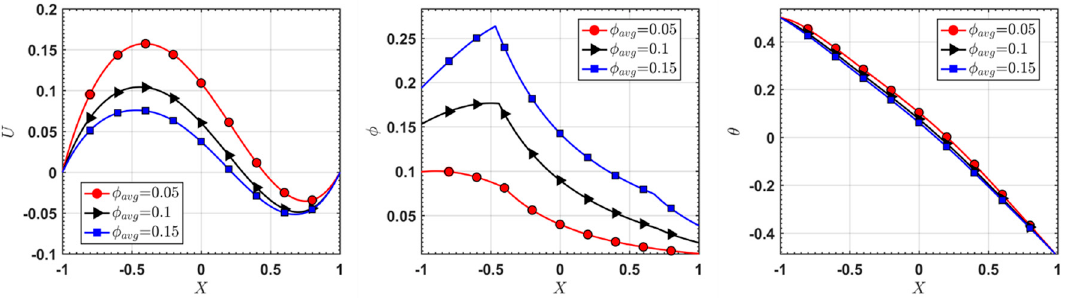
Figure 10. E ff ect of bulk (average) concentration ( φ avg ) on the velocity, concentration and temperature Figure 10. Effect of bulk (average) concentration ( 𝜙 ) on the velocity, concentration and temperature 𝑎𝑣𝑔 ◦ profiles, when Γ c = 1.0, Γ µ = 0.1, Γ g = 1, β = 10 , Le = 10, n = − 0.5, δ = 1, Ra = 2 and Br = profiles, when 𝛤 𝑐 = 1.0 , 𝛤 𝜇 = 0.1 , 𝛤 𝑔 = 1 , 𝛽 = 10° , 𝐿𝑒 = 10 , 𝑛 = −0.5 , 𝛿 = 1 , 𝑅𝑎 = 2 and 𝐵𝑟 = 5 .